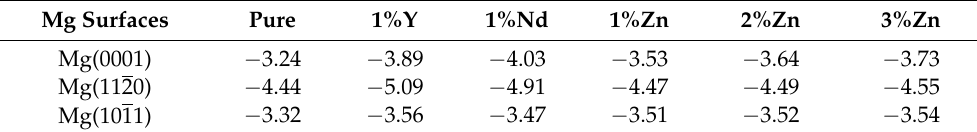
Table 2. E ads of RGD on the Mg and Mg alloys surfaces (eV).